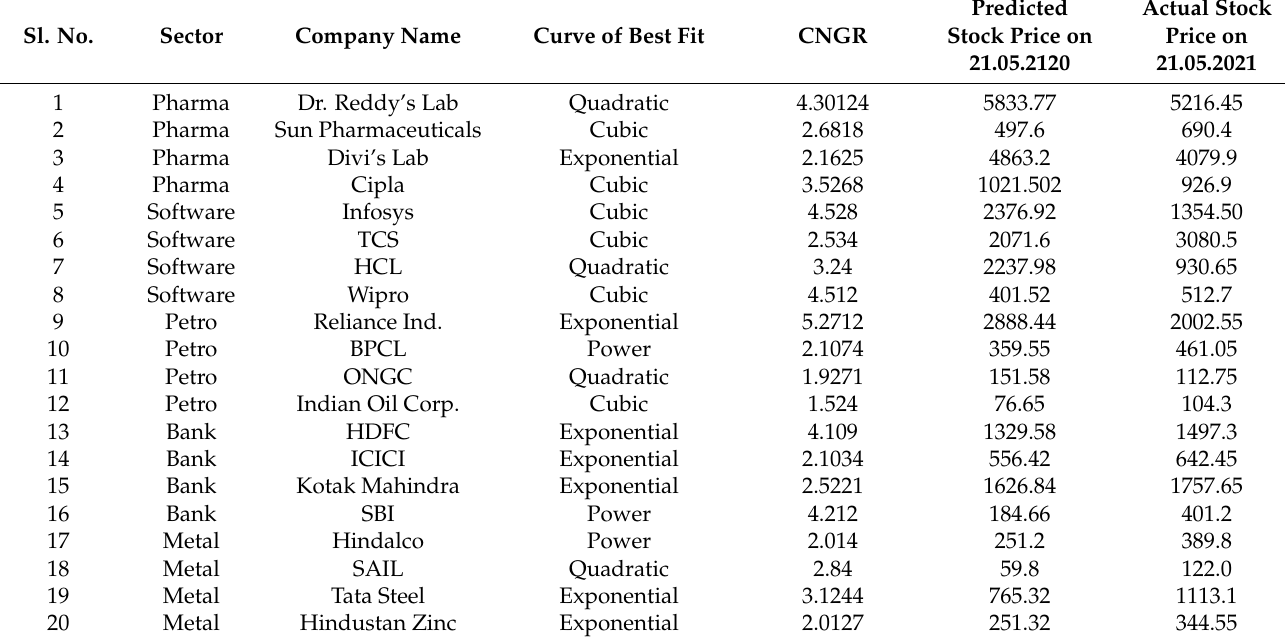
Table 2. Curve of best fit and CNGR of the companies.